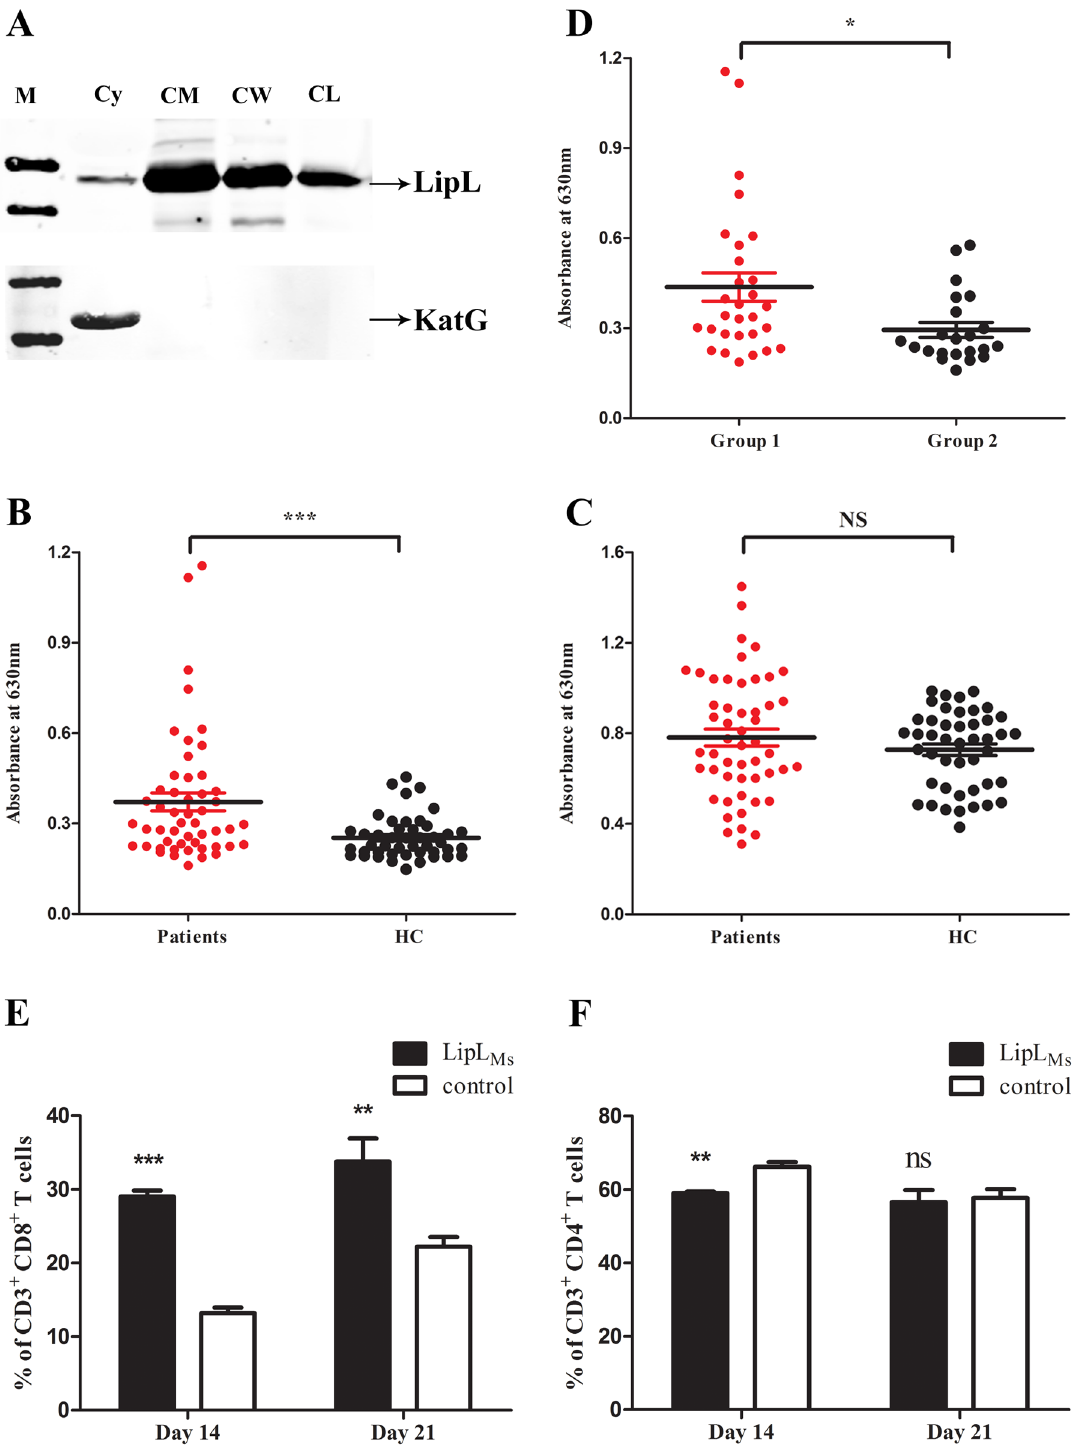
Fig 5. Subcellular localization, the humoral and cell-mediated immune responses of LipL. (A) Subcellular localization of LipL in M . smegmatis . Bacteria were lysed and fractionated to separate the cytoplasm (Cy) from the cell wall (CW). Equal amounts of protein (20 μ g) from each fraction were subjected to SDS-PAGE, transferred onto a nitrocellulose membrane, and probed with either monoclonal anti-His antibodies (top) or rabbit anti-KatG antiserum (bottom). (B and C) The humoral responses induced by the recombinant LipL Ms (B) and LipL E (C) proteins in TB patients compared with healthy donors. The plates were coated with purified LipL Ms or LipL E . ELISA reactions of LipL Ms and LipL E to the sera of either TB patients or healthy controls